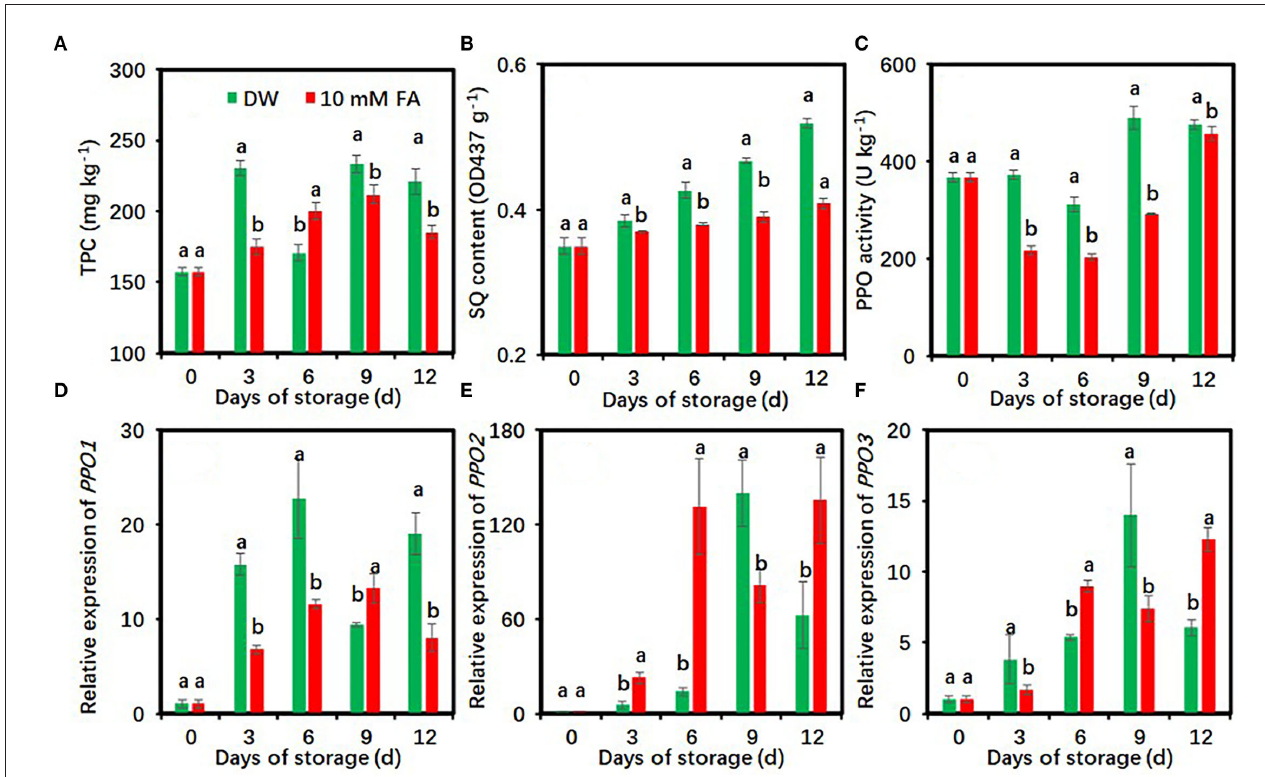
FIGURE 4 | Effects of 10mM FA treatment on total phenolic contents (A) , soluble quinone contents (B) , and the activity and gene expression of PPO (C–F) in taro slices during storage at 5 ◦ C. Each value is presented as means ± standard deviation (SD, n = 3). Statistical differences ( p ≤ 0.05) between the control and 10mM FA treatment at same time point are analyzed and indicated using different letters above the